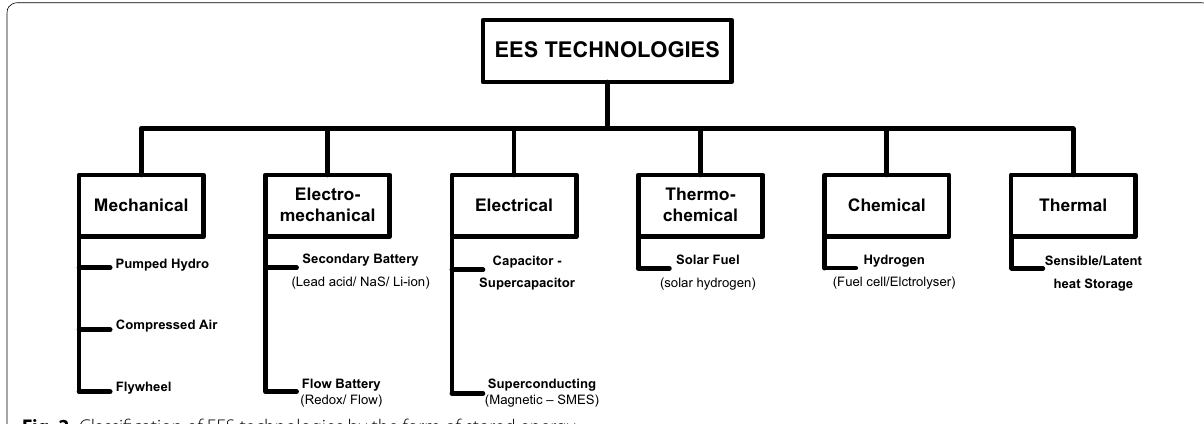
Fig. 2 Classification of EES technologies by the form of stored energy